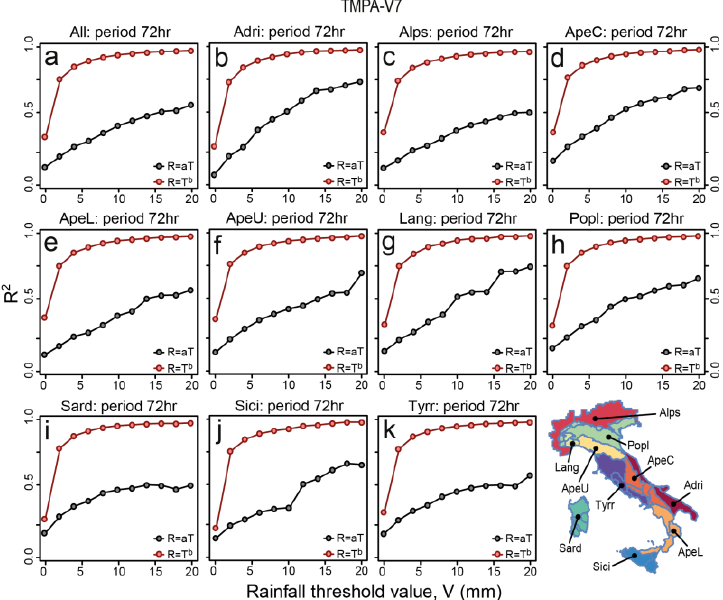
Figure 7. Linear (grey dots) and power-law (red dots) fitting (between TMPA-V7 rainfall estimates and VRF ground data) determination coefficients for the 72-h cumulative rainfall filtered using a peak over threshold approach taking values above different thresholds: 0, 2, 4, 6, 8, 10, 12, 14, 16, 18 and 20 mm. The different plots show results for different Italian morphological subdivisions: ( a ) entire Italian territory; ( b ) Adri; ( c ) Alps; ( d ) ApeC; ( e ) ApeL; ( f ) ApeU; ( g ) Lang; ( h ) Popl; ( i ) Sard; ( j ) Sici; ( k ) Tyrr.